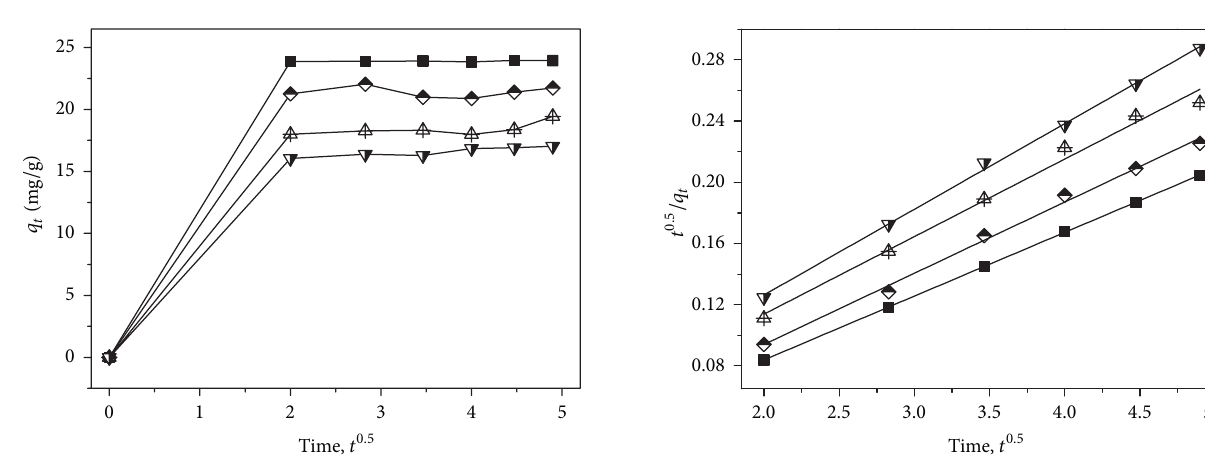
Figure 4: Intraparticle diffusion model for the adsorption of strontium ions on samples A (solid square), B (half-filled diamond), C (center up triangle), and D (half-filled down triangle).